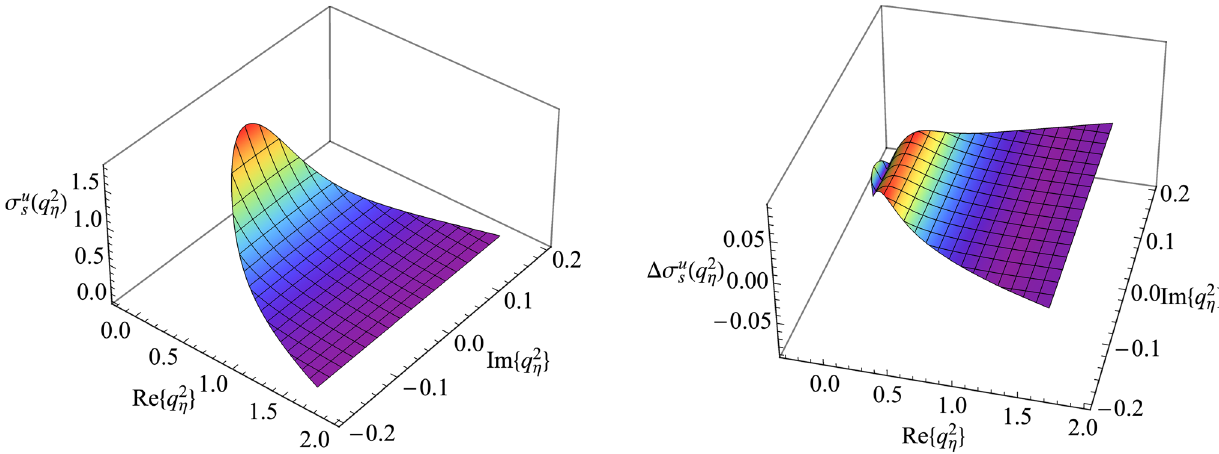
Fig. 3 Comparison of σ u s ( q 2 η ) and Δσ u s ( q 2 η ) for the u -quark on the complex plane ( P 2 = − m 2 π , η = 1 / 2, m π = 0 . 140 GeV)